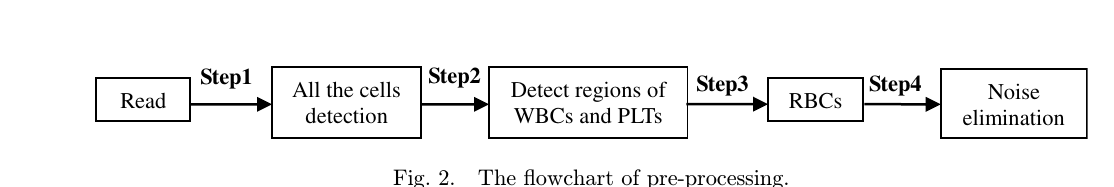
Fig. 1. Image pre-processing.